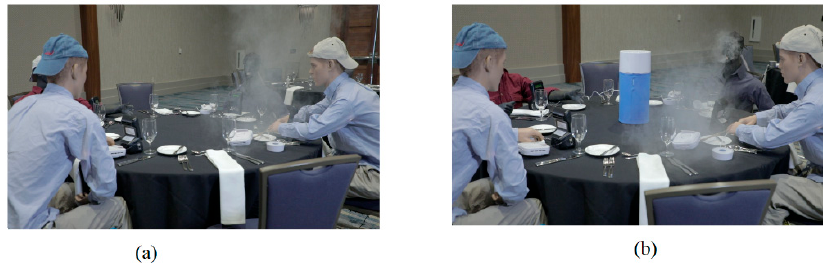
Figure 15. The dispersion processes of stage fog ( a ) without and ( b ) with purifier in a ballroom.